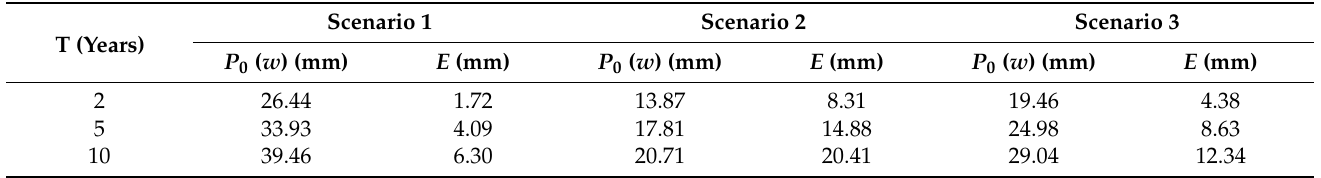
Table 4. Weighted P 0 values ( P 0 ( w )) and surface runoff depth ( E ) generated on the university campus for each scenario